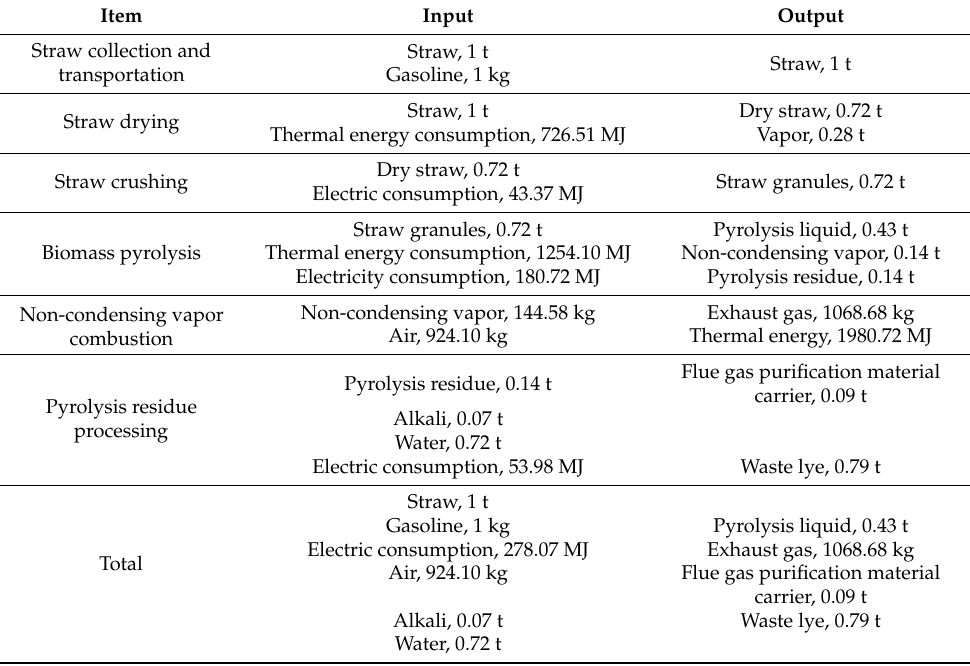
Table 2. Partial material and energy inventory of the non-phase-transition drying pyrolysis and mass conversion technology.